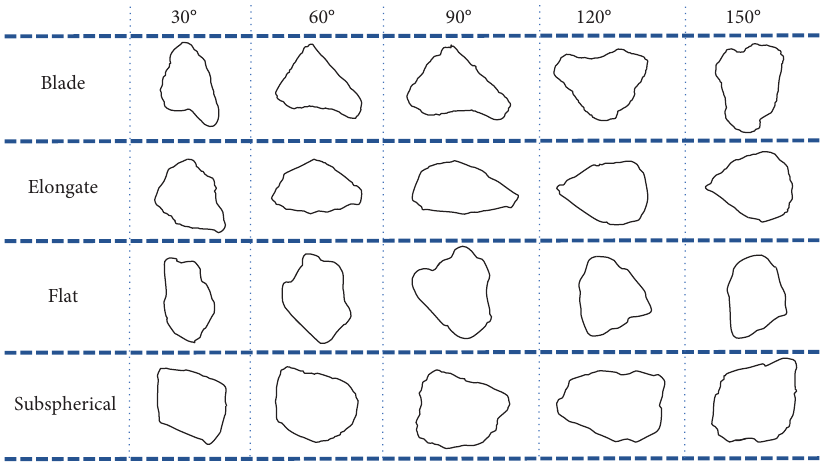
Figure 3: Particle contours of diferent acquisition